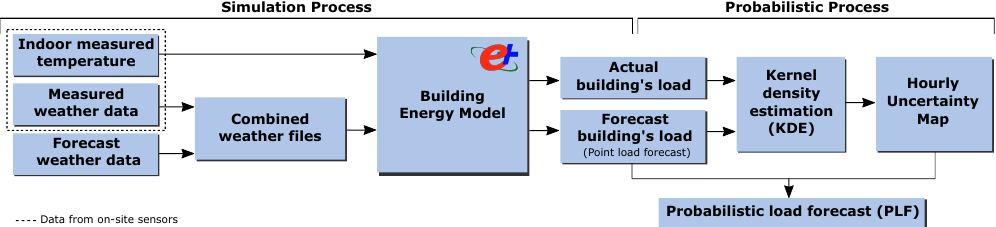
Figure 1. Components and steps of the proposed probabilistic load forecasting methodology based on white-box models (building energy model